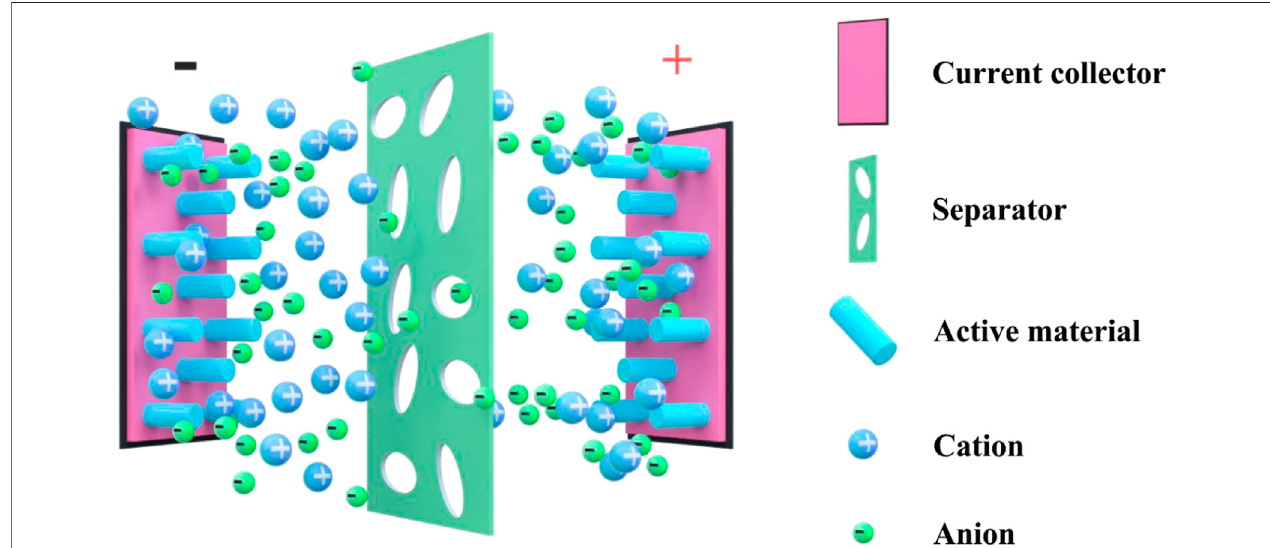
FIGURE 1 | Basic structure of hybrid